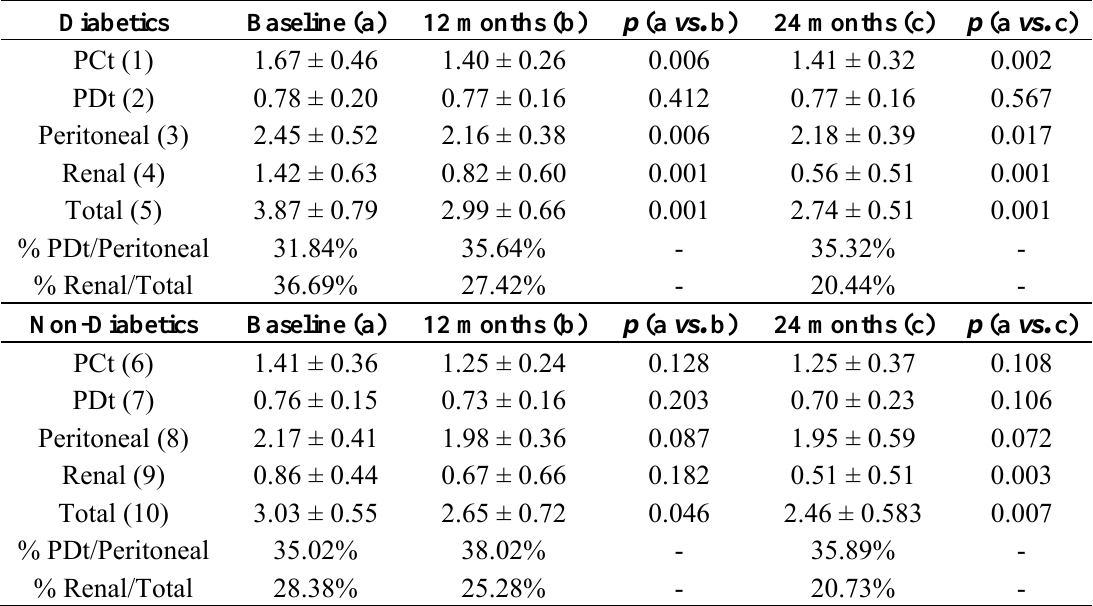
Table 4. Urea Kt/V Index.